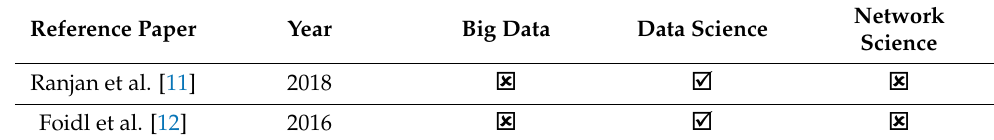
Table 1. Summary and comparison of our survey and current recent research.